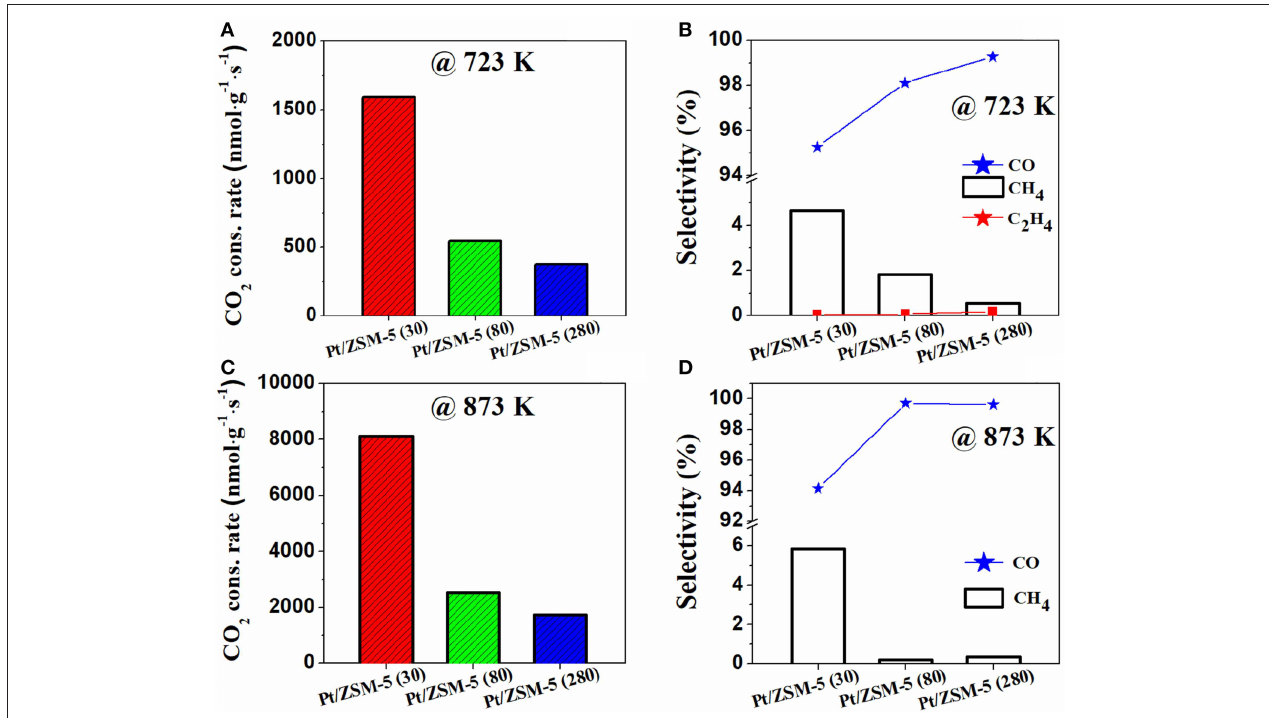
FIGURE 6 | CO 2 consumption rate and distribution of products at 723 and 873K over 0.5% Pt supported on H-ZSM-5 catalysts. (A) CO 2 consumption rate at 723K, (B) Selectivity at 723K (C) CO 2 consumption rate at 873K, (D) Selectivity at